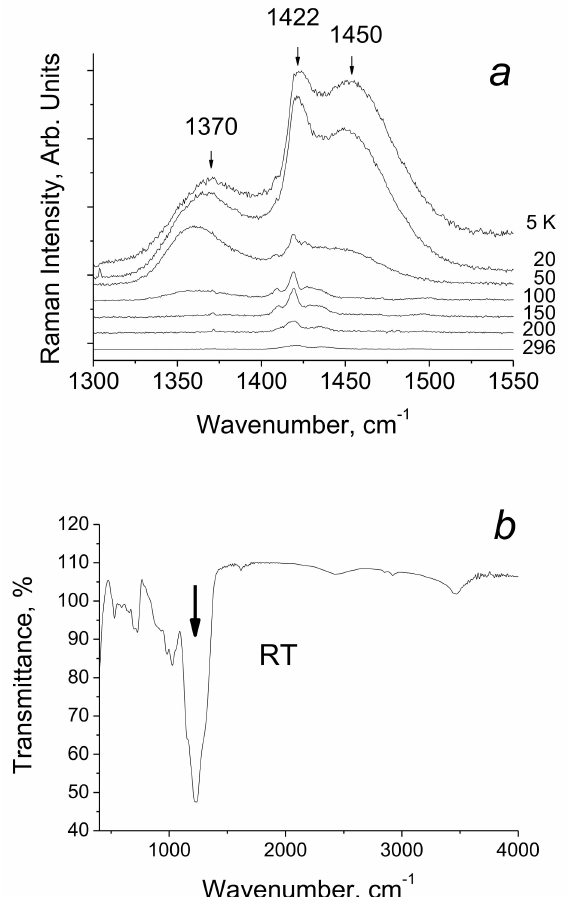
Figure 21. ( a ) Raman spectra of [(DMF) 2 H] 2 [W 6 Cl 14 ] in the region of proton vibrations at various temperatures. ( b ) IR-spectrum of [(DMF) 2 H] 2 [W 6 Cl 14 ] at room temperature [30]. The arrow shows the expected position of the hydrogen bond absorption band. The corresponding Raman bands in this region rise only at low temperatures ( a